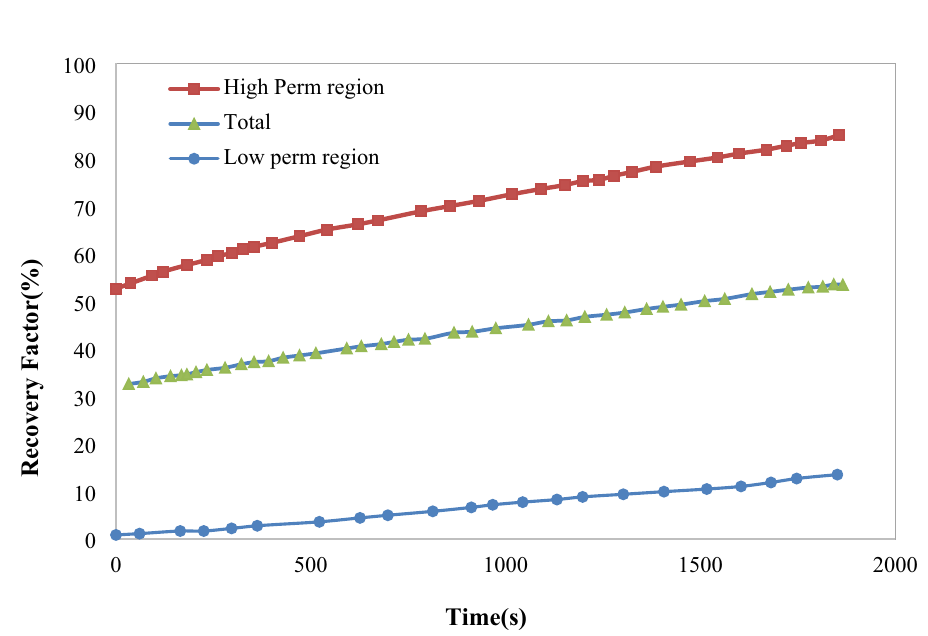
Table 6. Comparison of the results for experimental and simulation studies in gel flooding process.